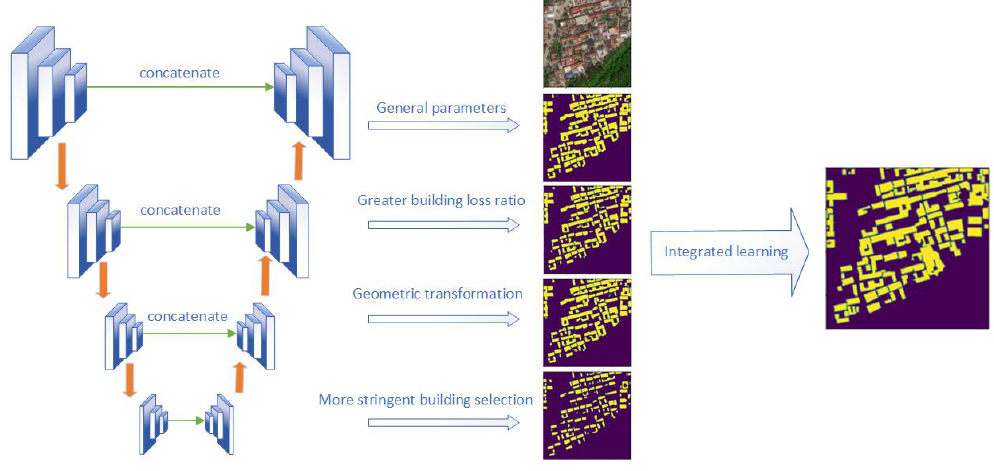
Figure 6. Ensemble